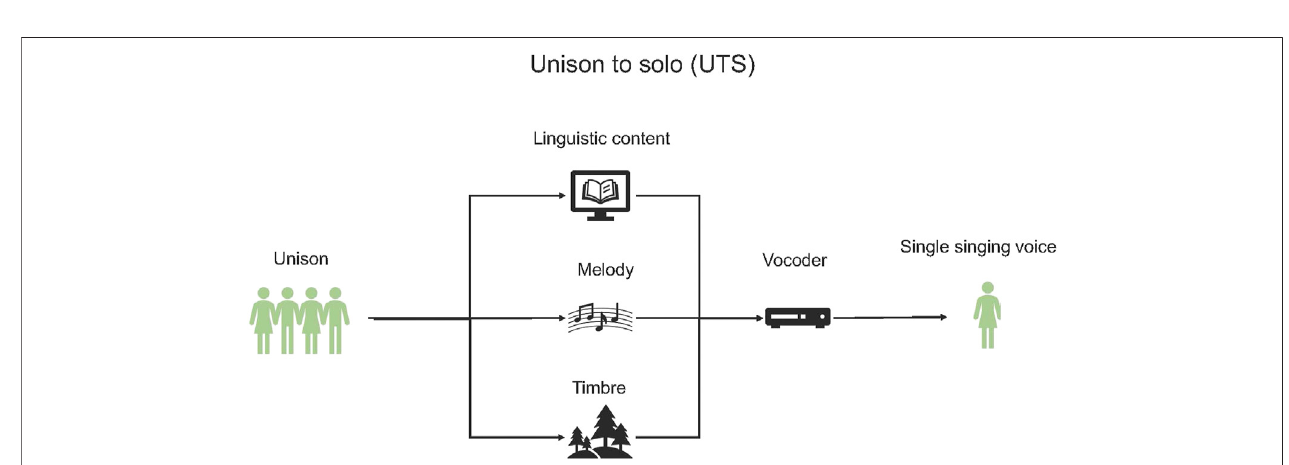
FIGURE 2 | Diagram of the Solo-to-Unison (STU)